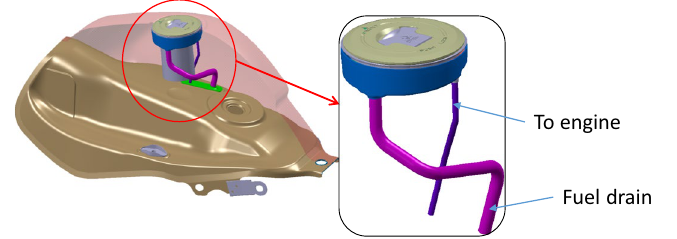
Figure 7. Construction of motorcycle fuel cap.